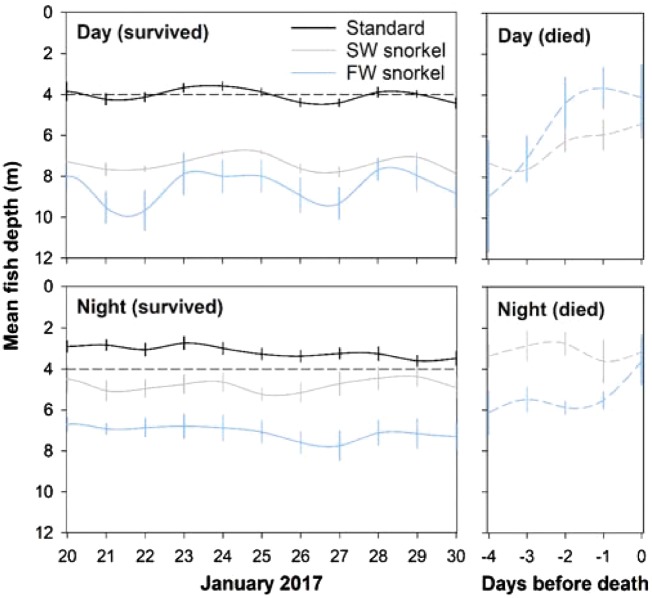
On the left, mean depth of tagged surviving individuals on each study day separated between day and night periods for standard (black), SW snorkel (grey), and FW snorkel fish (blue solid line) from 20 to 30 January 2017. On the right, mean depth of dying individuals on −4 − 0 days before death separated between day and night periods for SW snorkel (grey) and FW snorkel fish (blue dashed line).